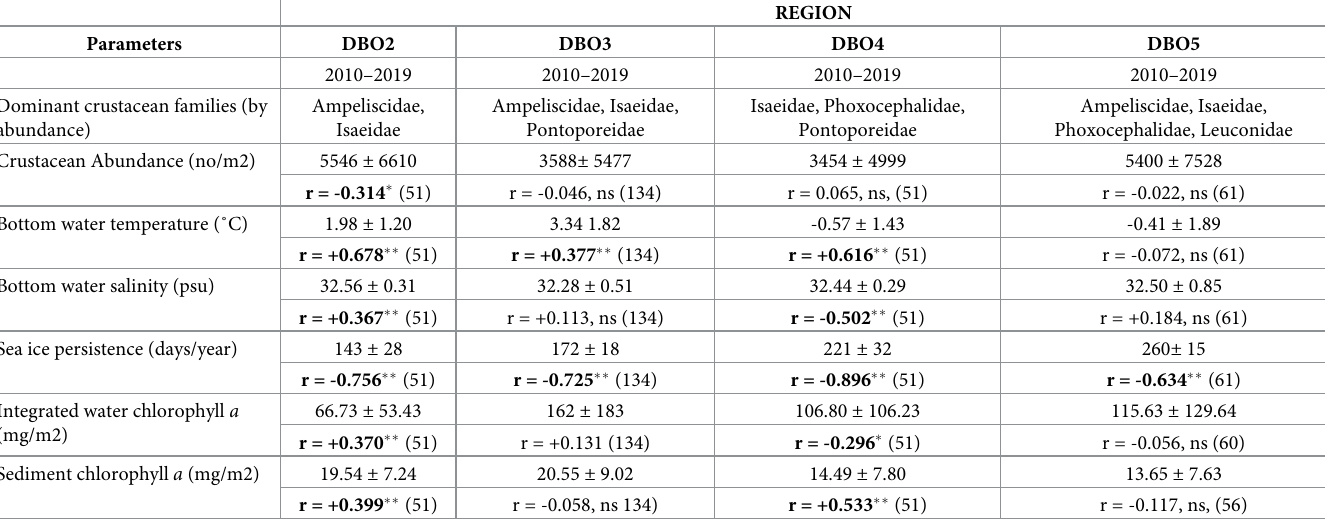
Table 2. Changes in infaunal crustacean community composition and abundance coincident with bottom water temperature and salinity, sea ice persistence (days from Sept-to Sept), and integrated water column and sediment chlorophyll in DBO regions 2–5 for the period